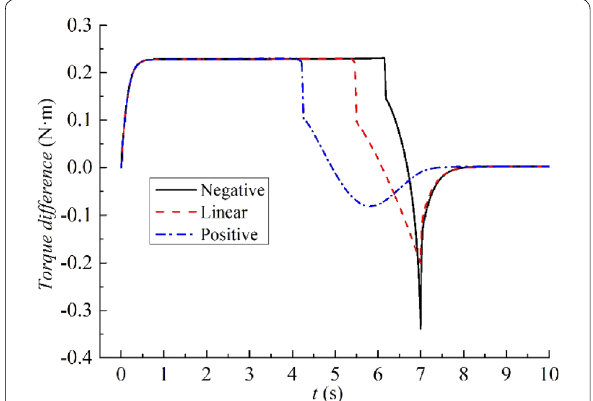
Figure 9 Driven torque differences between Q Q 25 L/min under different =